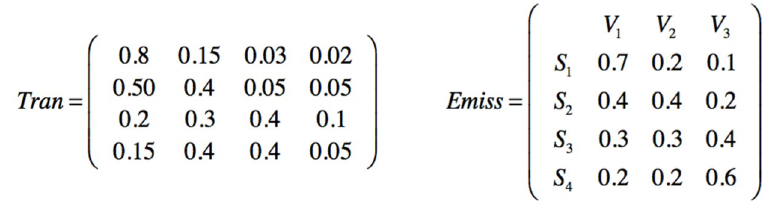
Figure 31. Prior transition and emission matrices for end states and mitigative safety barriers.